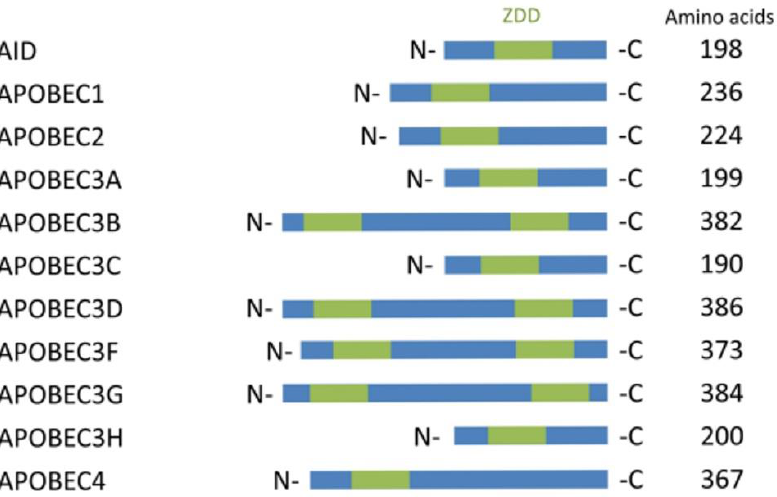
Figure 1. APOBEC family proteins for C to U editing.